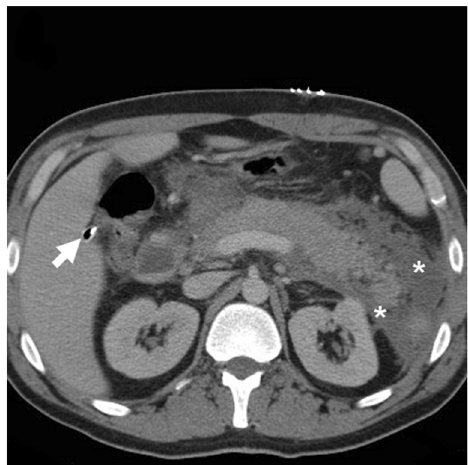
Fig. 17 Postoperative acute pancreatitis (serum lipase 15,000 U/L) after laparo-endoscopic intraoperative rendezvous cholecystectomy. Twenty- four hours after surgery, contrast-enhanced CT with drainage in place ( thick arrow ) showed preserved enhancement of the pancreatic gland and development of peripancreatic effusion (*). The patient was treated with positioning of nasobiliary drain and eventually developed pseudocyst formation